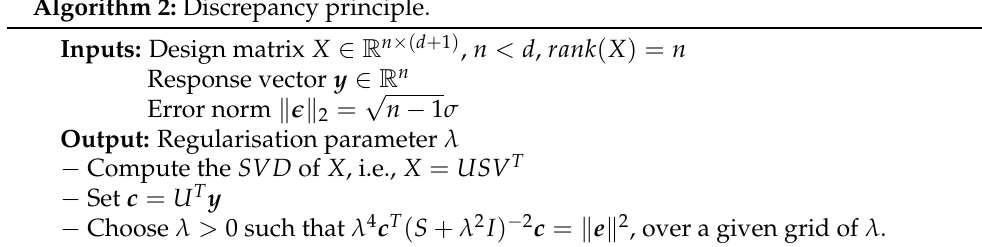
Algorithm 2: Discrepancy